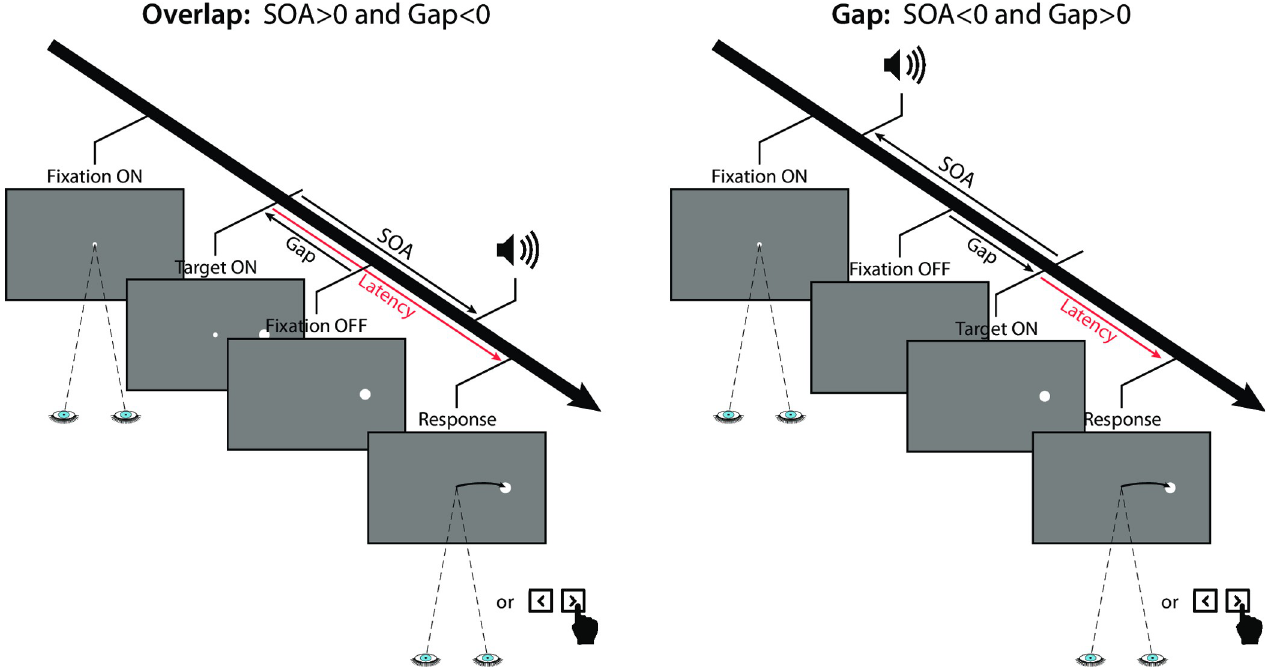
Fig 2. Time course of a trial illustrating the overlap (left) and gap (right) situations, the beep signal and the response mode for the experiments. A central fixation spot was presented for a random duration ranging from 750 to 1250 ms. The target appeared left/right at an eccentricity of 8˚, either simultaneously (no-gap or step conditions), before (overlap conditions) or after the fixation offset (gap conditions). A short beep was played either before or after target onset (SOA ranging from − 120 to +120 ms). In baseline conditions, no beep was played. Participants were instructed to shift their gaze towards the target (Experiments 1a, 2 and 3) or to indicate the target side by pressing the left/right mouse button (Experiment 1b), as fast and as accurately as possible. The response latency corresponded to the delay between target onset and the start of the saccade or the mouse-button press.